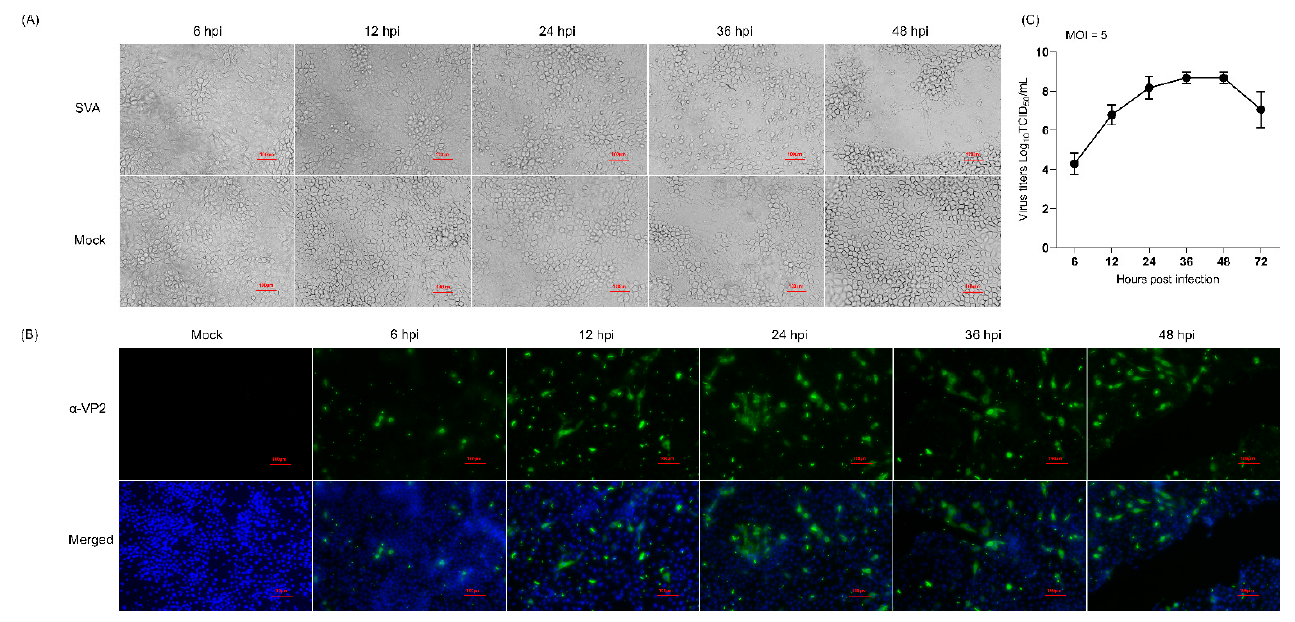
Figure 1. Characterization of the proliferation dynamics of Senecavirus A (SVA) in porcine kidney epithelial (PK-15) cells. ( A ) The cytopathic effect of PK-15 cells caused by SVA infection. PK-15 cells were mock-infected or infected with SVA SDta/2018 at an MOI of 5 50% tissue culture infectious dose (TCID 50 )/cell for 6, 12, 24 and 36 h, respectively. Scale bars, 10 μ m. ( B ) Confirmation of SVA proliferation in PK-15 cells by indirect immunofluorescence assay (IFA) using the SVA VP2-specific monoclonal antibody (mAb) 2F5 ( α -VP2) as the primary antibody. Cell nuclei were counterstained with 4 ′ , 6-diamidino-2-phenylindole (DAPI). Scale bars, 100 μ m. ( C ) One-step growth curve of SVA in PK-15 cells. The viral titer was determined by measuring the TCID 50 using a microtitration assay. The data were recorded as means ± standard deviation (SD) from three independent